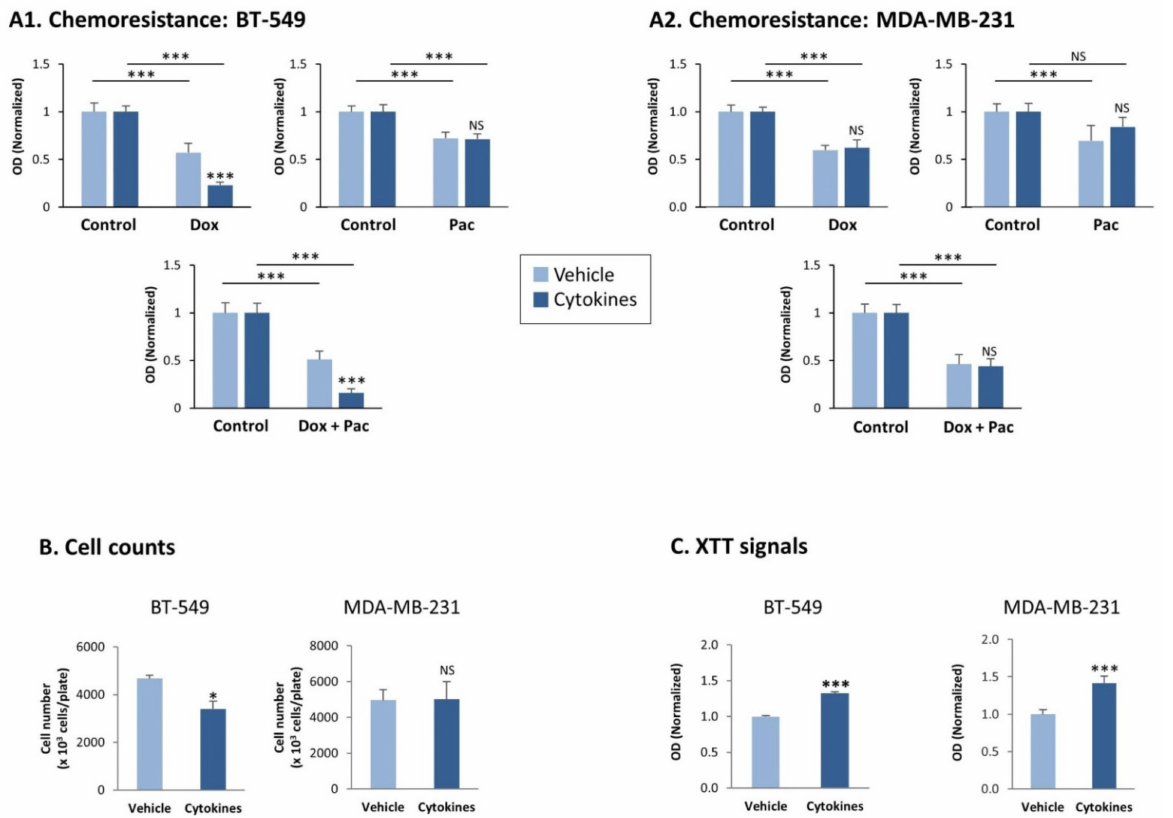
Figure 5. Continuous TNF α + IL-1 β stimulation does not consistently affect chemoresistance and proliferation of TNBC cells, but leads to increased levels of mitochondrial enzymes in the tumor cells. BT-549 and MDA-MB-231 cells were continuously stimulated by TNF α + IL-1 β , or treated by a vehicle control (as described in Figure 1). ( A ) Chemoresistance of BT-549 cells ( A1 ) and of MDA-MB-231 cells ( A2 ). The cells were grown for 24 h in the presence of the cytokines/vehicle, with doxorubicin (dox; 5 µ M) and/or paclitaxel (pac; 350 nM). Control cells were grown in the presence of the solubilizer of the drugs. The results of a representative experiment of n > 3 are presented, where the OD values of the vehicle control group were given the value of 1. *** p < 0.001. NS, Not significant. ( B ) Cell counts, determining the numbers of BT-549 cells and MDA-MB-231 cells 72 h after seeding in similar numbers (cytokine- vs. vehicle-treated cells). Average ± SD values of n = 3 is presented for each cell type.* p < 0.05. NS, not significant. ( C ) XTT signals of BT-549 cells and MDA-MB-231 cells grown for 72 h after seeding in similar numbers (cytokine- vs. vehicle-treated cells). The XTT values of a representative experiment of n = 3 are presented, where the values in the vehicle control group were given the value of 1. *** p < 0.001. NS, not